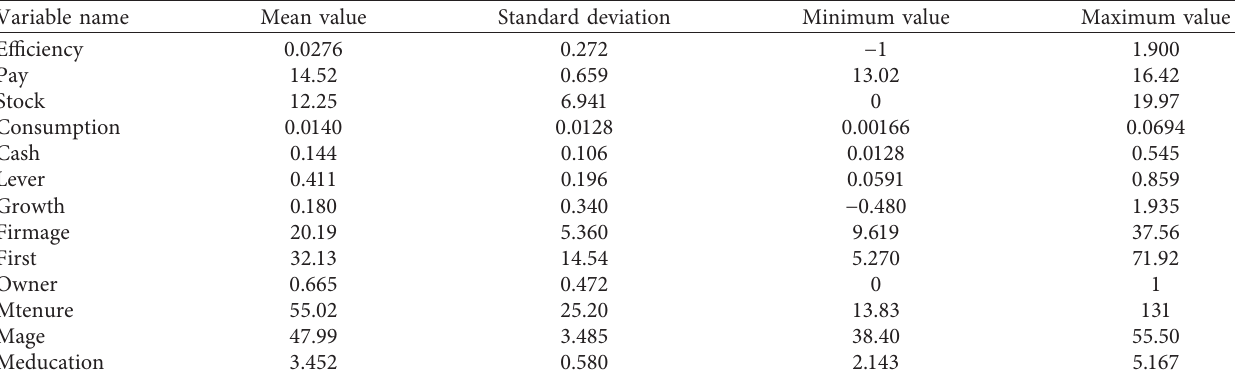
Table 3: Descriptive statistics of all